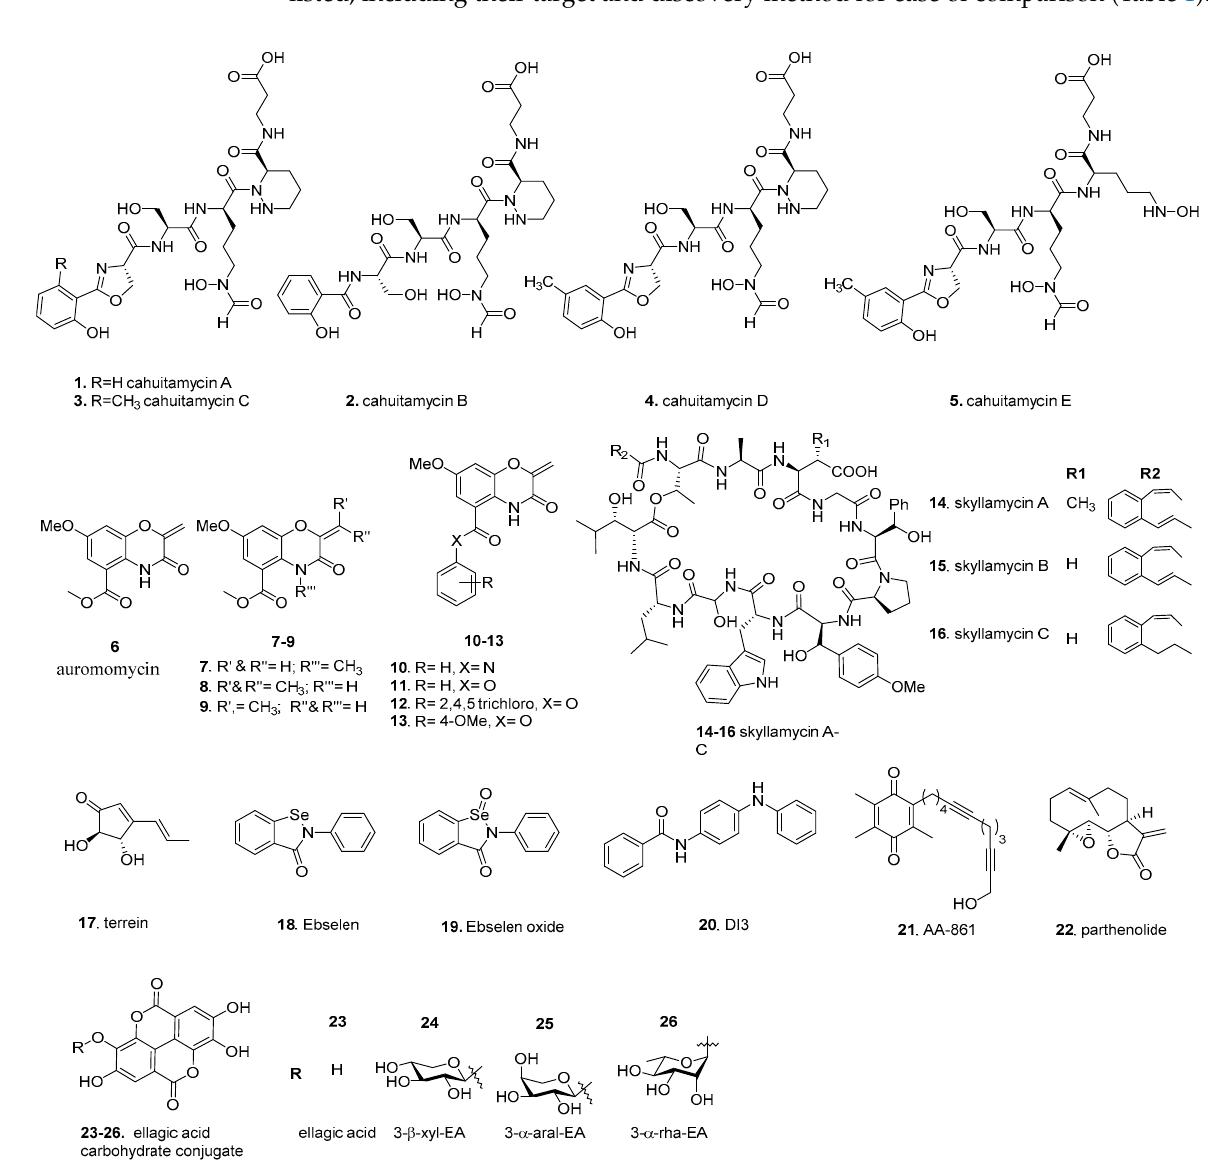
Figure 3. Screening-based discovery of biofilm inhibitors